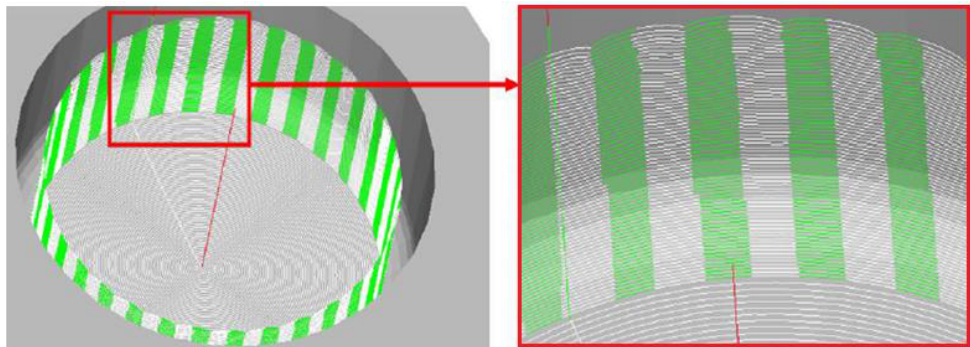
Figure 4. The schematic diagram of the constant stepover strategy.